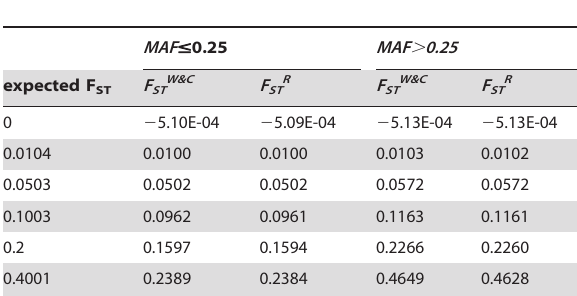
Table 2. Estimated F ST values changed allele frequency distributions, n =50, k